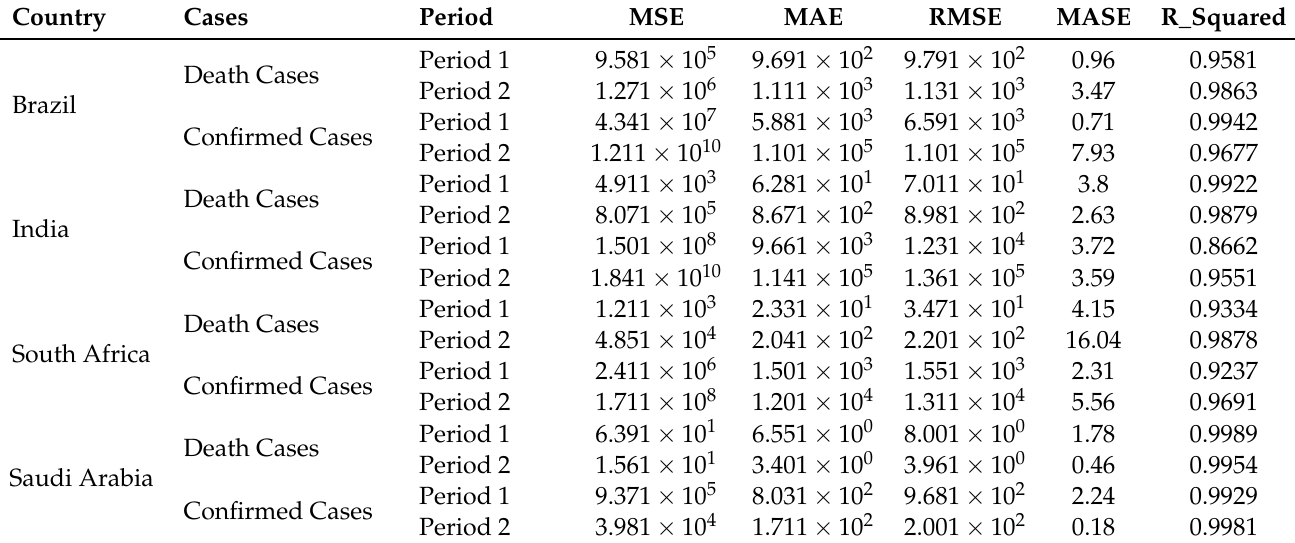
Table 5. COVID-19 spread forecasting results in countries with single spread wave based statistical evaluation criteria.